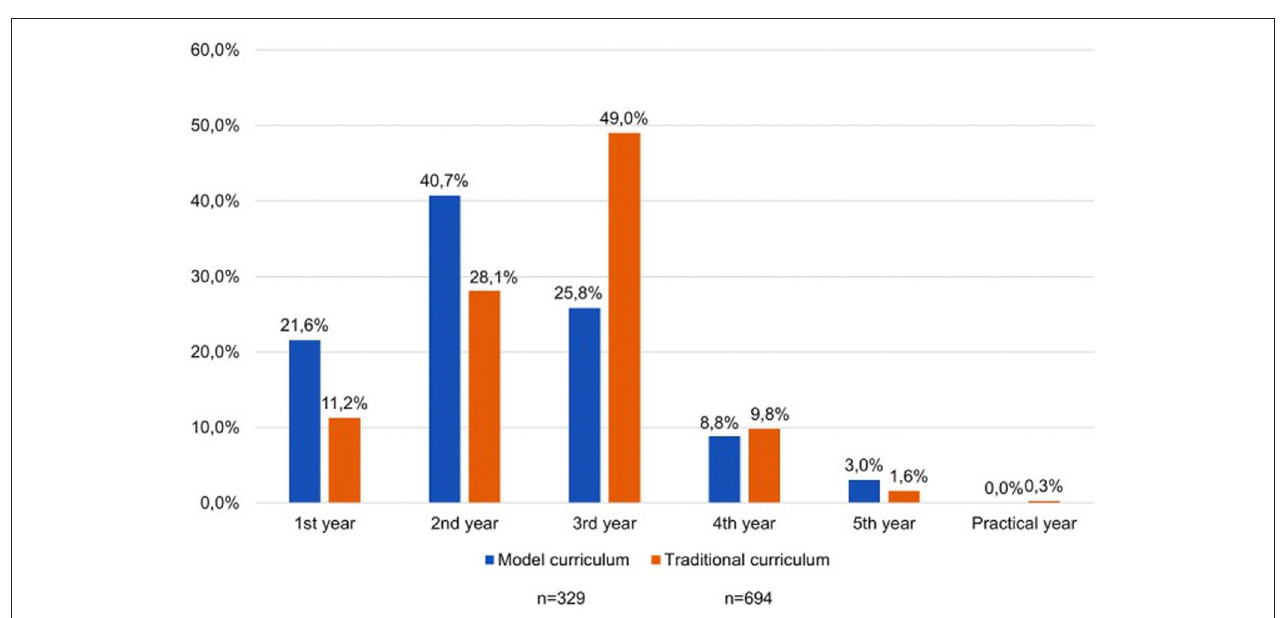
medical faculty did not offer any USMed at all. The third most commonly listed perceived barrier ( n = 198, 19.1%) was an overlap of offered USMed with other university